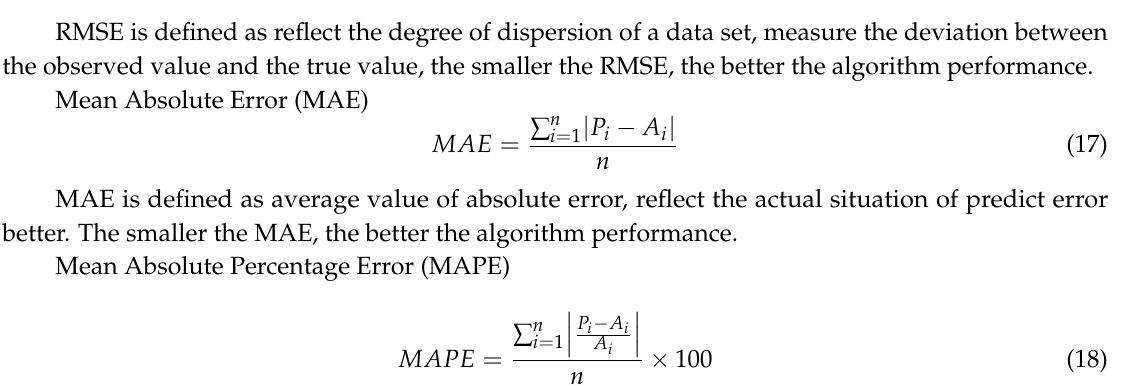
Table 5. Predict model test results.